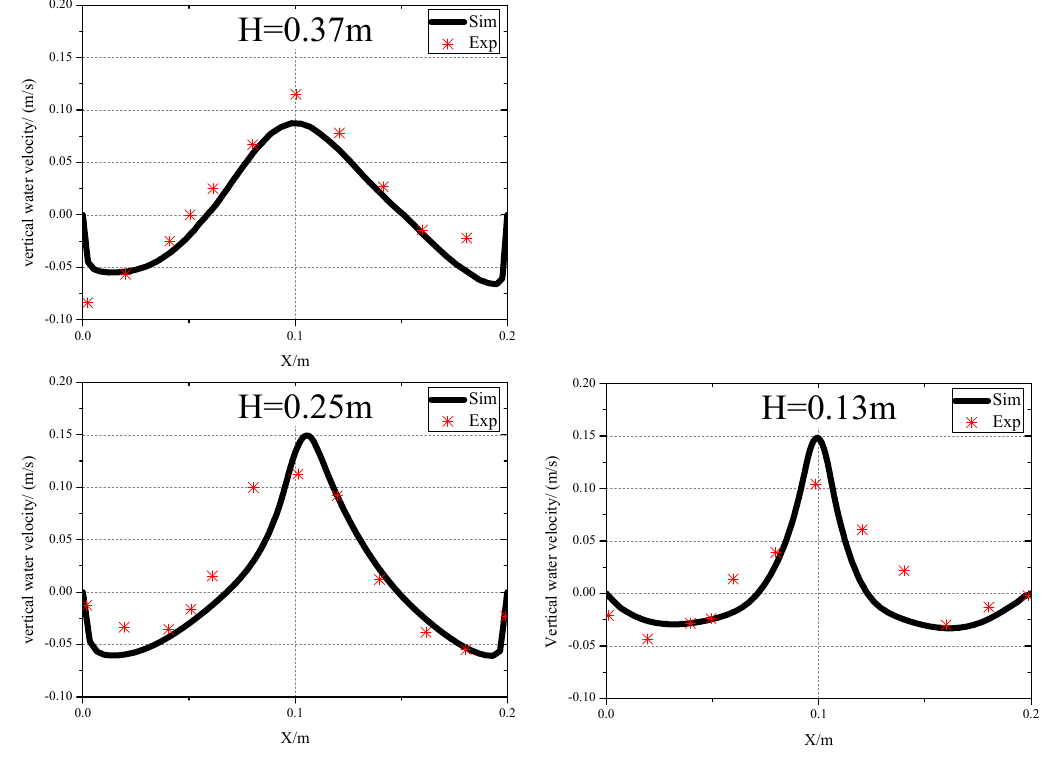
Figure 2. Comparison of the experimental and simulated long time-averaged vertical liquid velocity profiles.